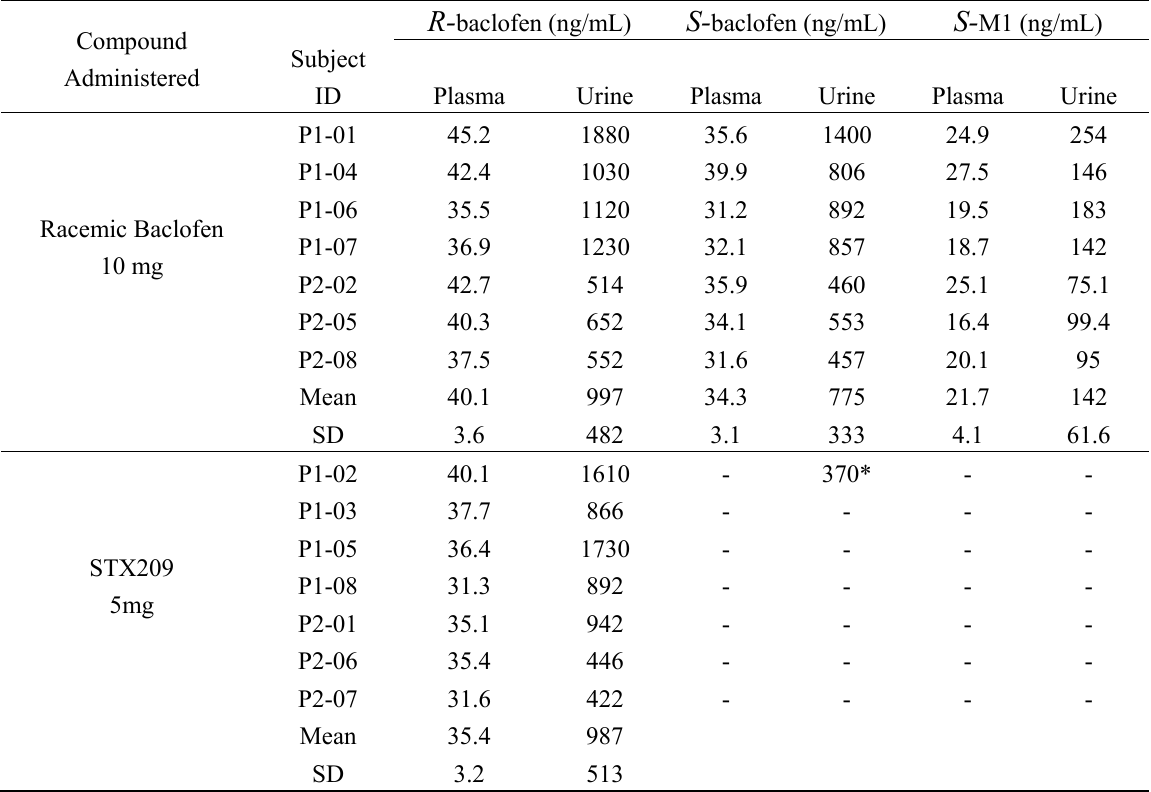
Table 1. Concentration of R- and S-baclofen, and S-M1 in human plasma and urine after administration of either racemic baclofen or STX209. Data provided to one decimal place or 3 significant figures. *Urine sample was considered